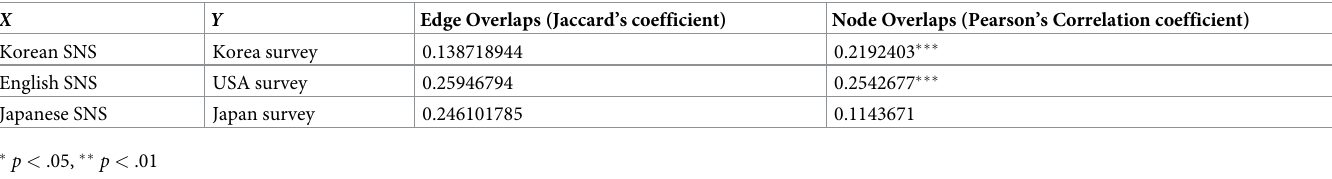
Table 8. Network overlaps (SNS vs.